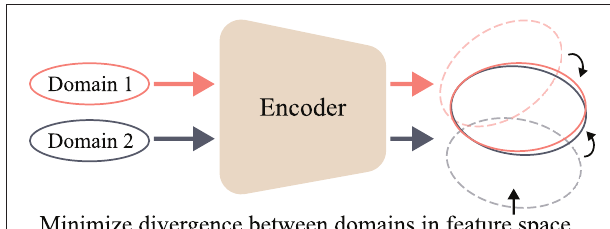
FIGURE 7 | Concept of explicit TL-based methods. The alignment can be achieved by minimizing a divergence between different